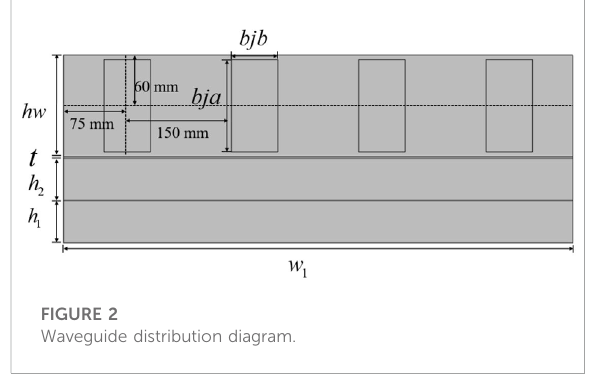
FIGURE 2 Waveguide distribution diagram.